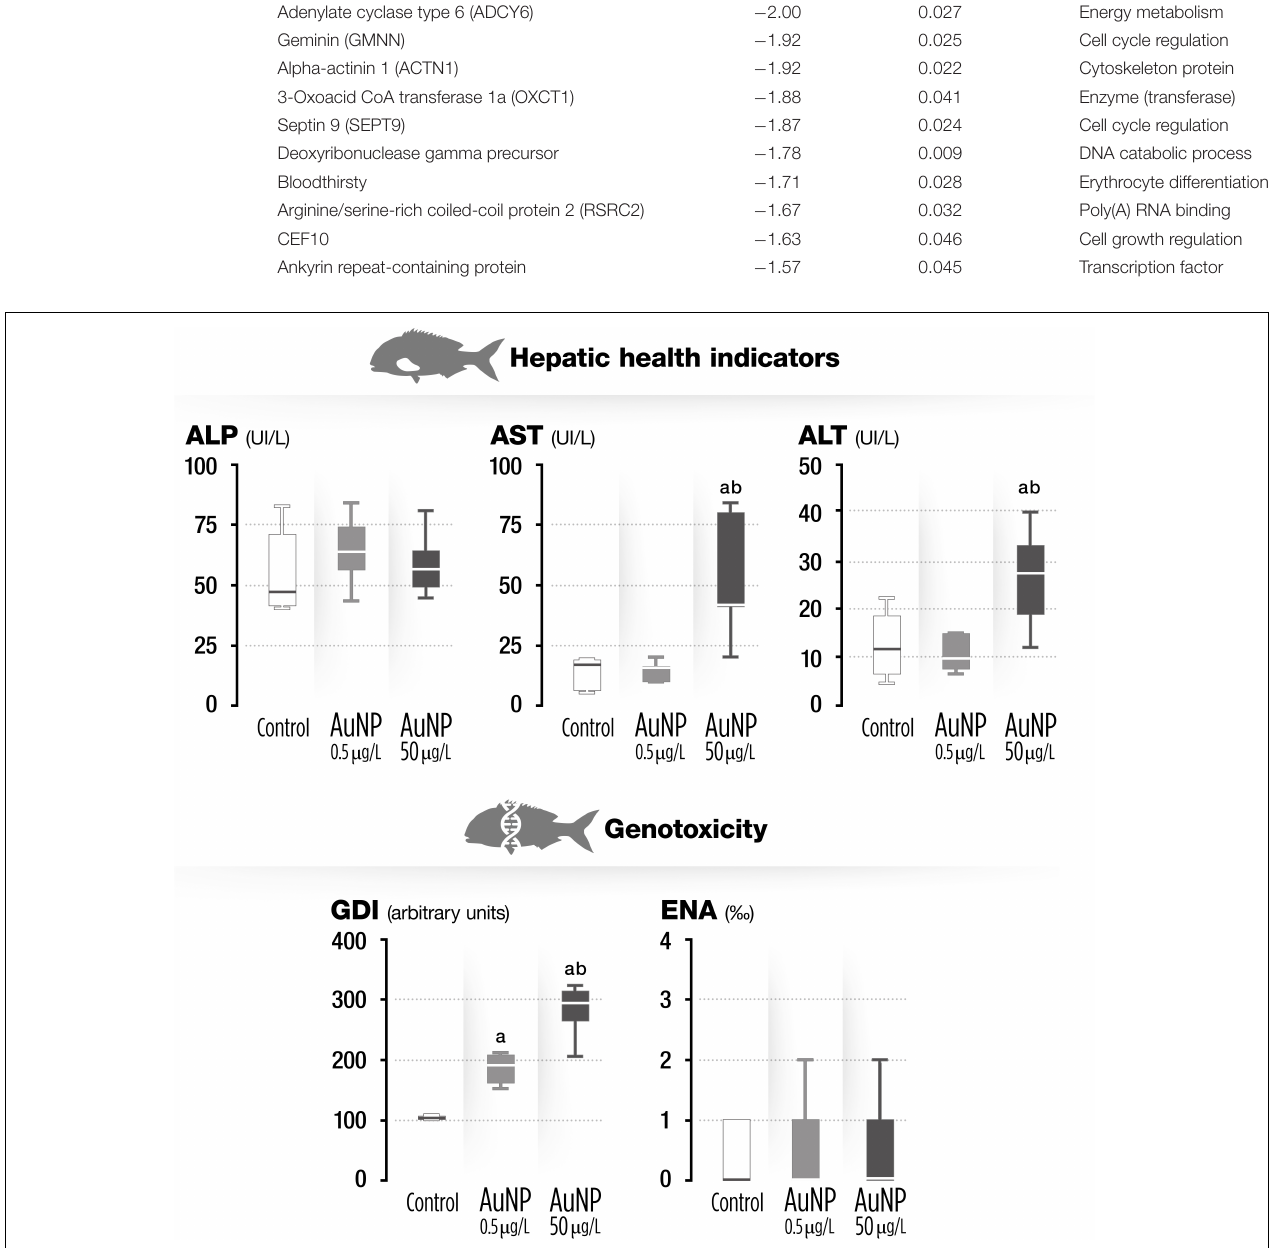
FIGURE 2 | Plasma alkaline phosphatase (ALP), plasma aspartate aminotransferase (AST), plasma alanine transaminase (ALT), blood genetic damage indicator (GDI) and erythrocytic nuclear abnormalities (ENA) frequency of Sparus aurata exposed to gold nanoparticles (AuNP) for 24 h. Values represent the mean ± standard error. Significant differences ( p < 0.05) are: a versus control; b versus 0.5 µ g/L AuNP.